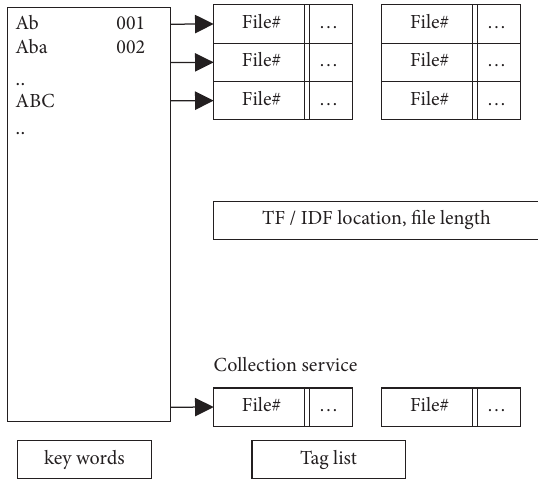
Collection service